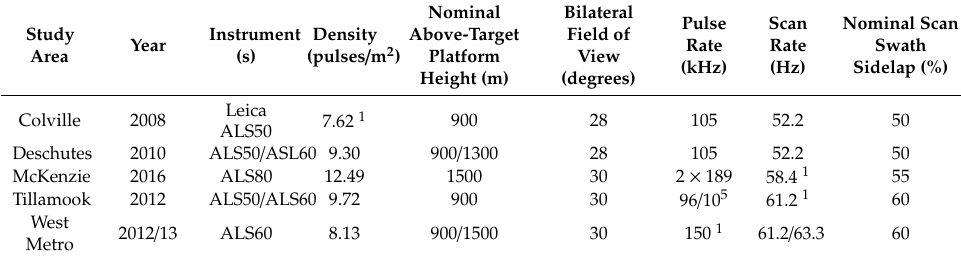
Table 2. Timing and instrument specifications of ALS